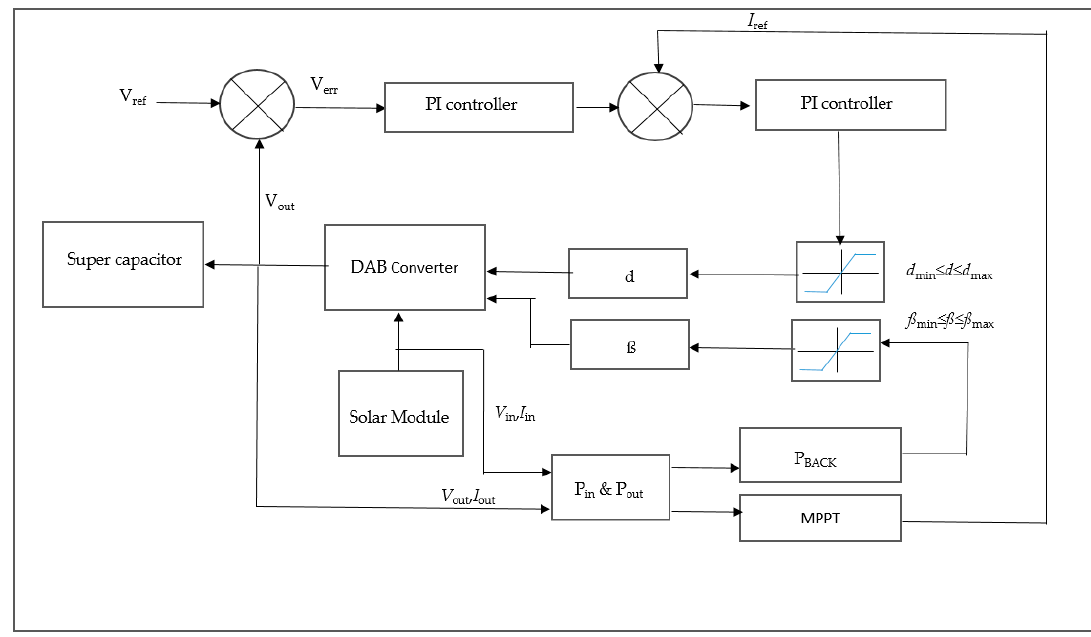
Figure 9. Blended SPS-ESPS digital control algorithm control loop.